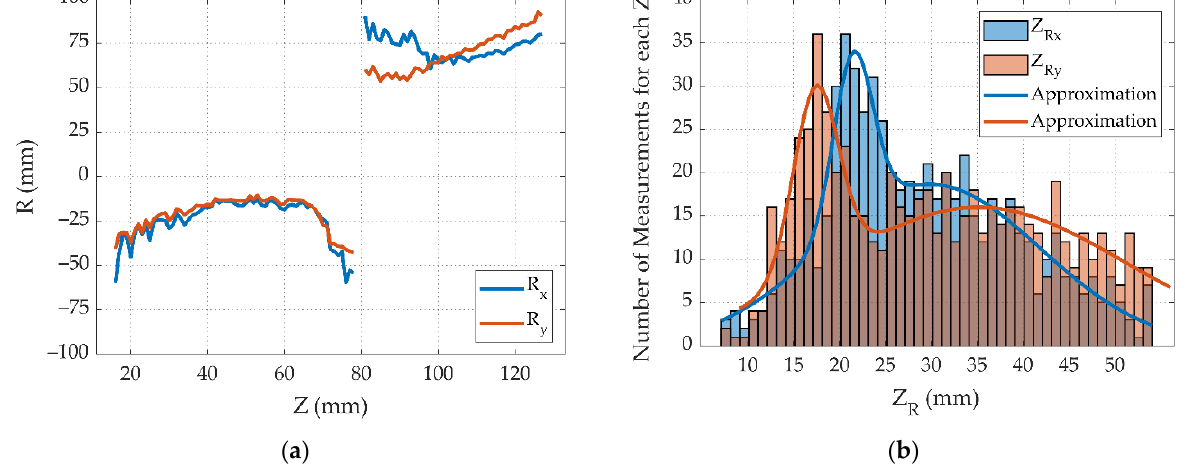
Table 3. Spatial parameters of the Satsuma laser